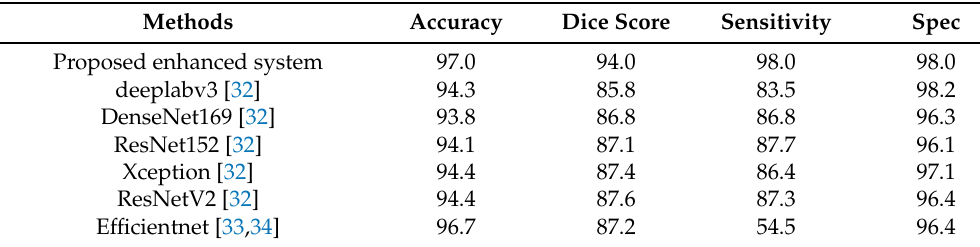
Table 5. Performance analysis (%) and comparison of the proposed method with existing pre-trained models on the ISBI 2017 datatest.